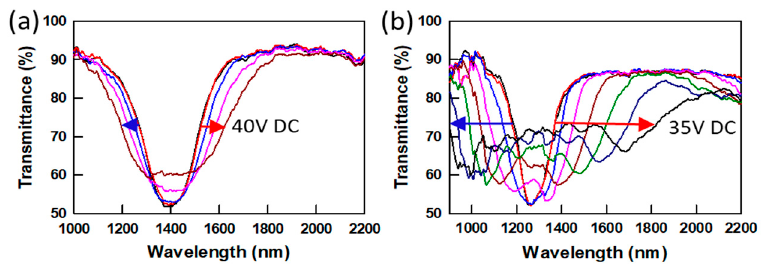
Figure 7. Transmission spectra of PSCLCs formulated with 3 wt% R1011, 91 wt% MLC-2079 and ( a ) 6 wt% purified C6M with an initial ion density of 3 × 10 13 ions cm − 3 and ( b ) 6 wt% purified chiral LCM (SL04151) with an initial ion density of 3.1 × 10 13 ions cm − 3 . Cells with 15 μ m thickness were used and irradiated with 200 mW cm − 2 UV for 30 min.